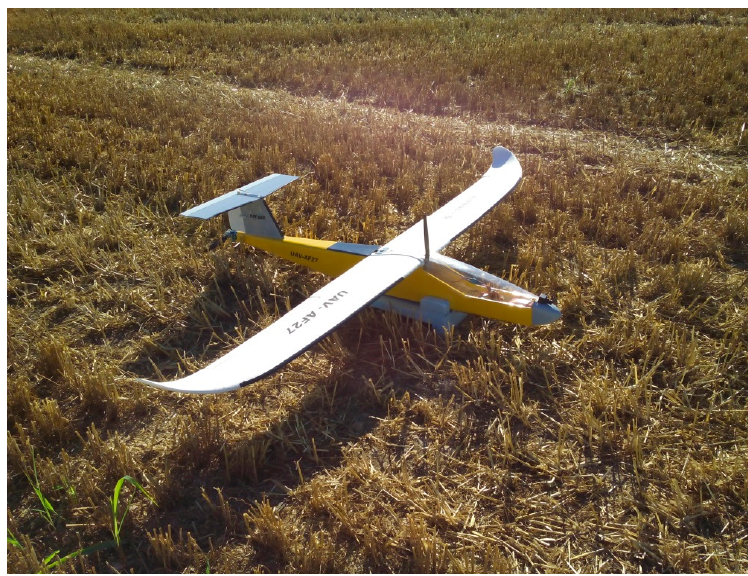
Figure 2. The Atmos-6 UAV operated by CATUAV (Moià, Catalonia, Spain), which was used as the platform for multispectral data acquisition.